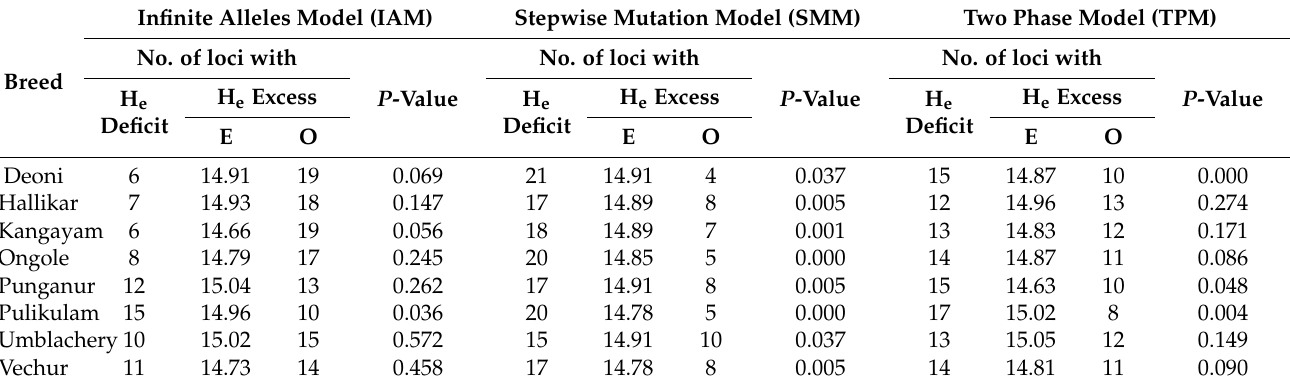
Table 2. Sign test to evaluate zebu cattle breeds for mutation drift equilibrium under different